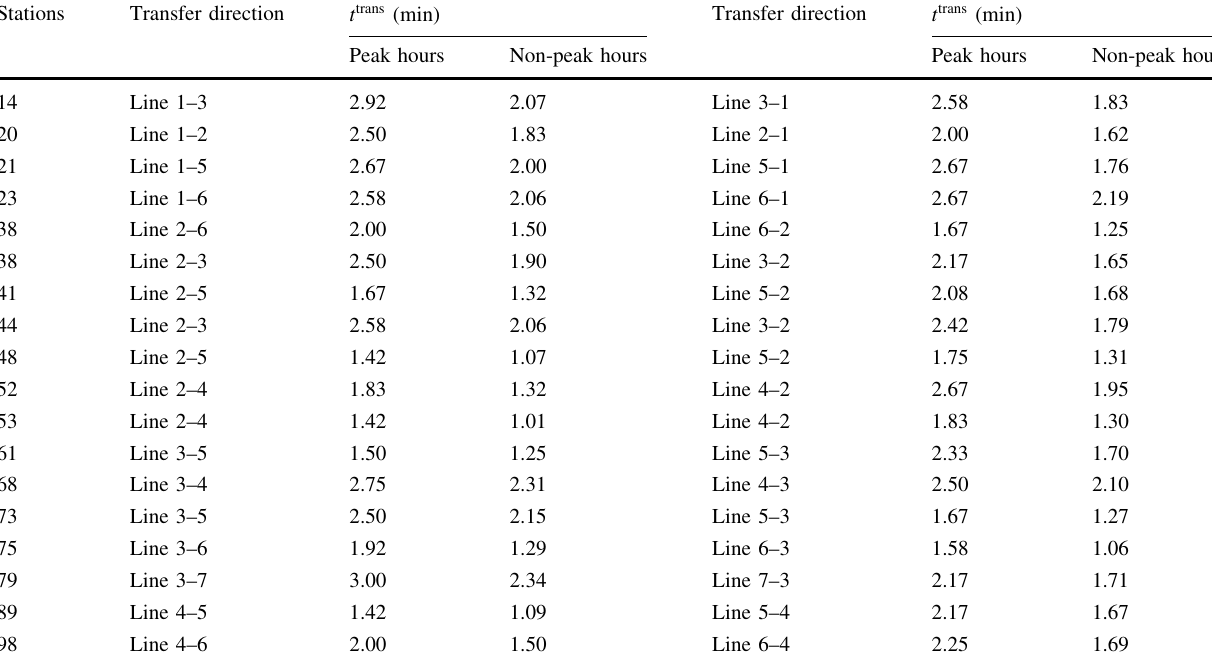
Table 2 Transfer time at transfer stations during peak and non-peak hours